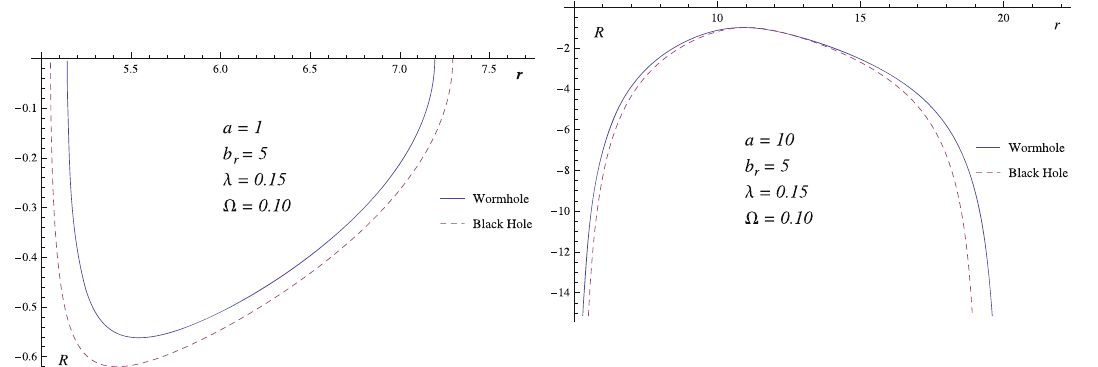
Fig. 1 a At the left panel it is shown the ratio between the Casimir energy density inside the cavity in the considered spacetimes and in the Minkowsky one, which orbit both the rotating D–S wormhole and Kerr